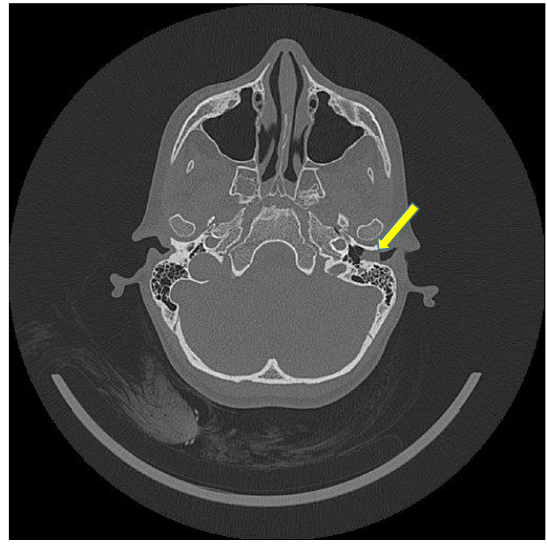
Fig. 1 Axial CT scan view of the skull corresponding to the temporal bone region showing the lesion at EAC (yellow arrow) with obvious intact tympanic membrane, middle ear cavity, and well-pneumatized mastoid air cells